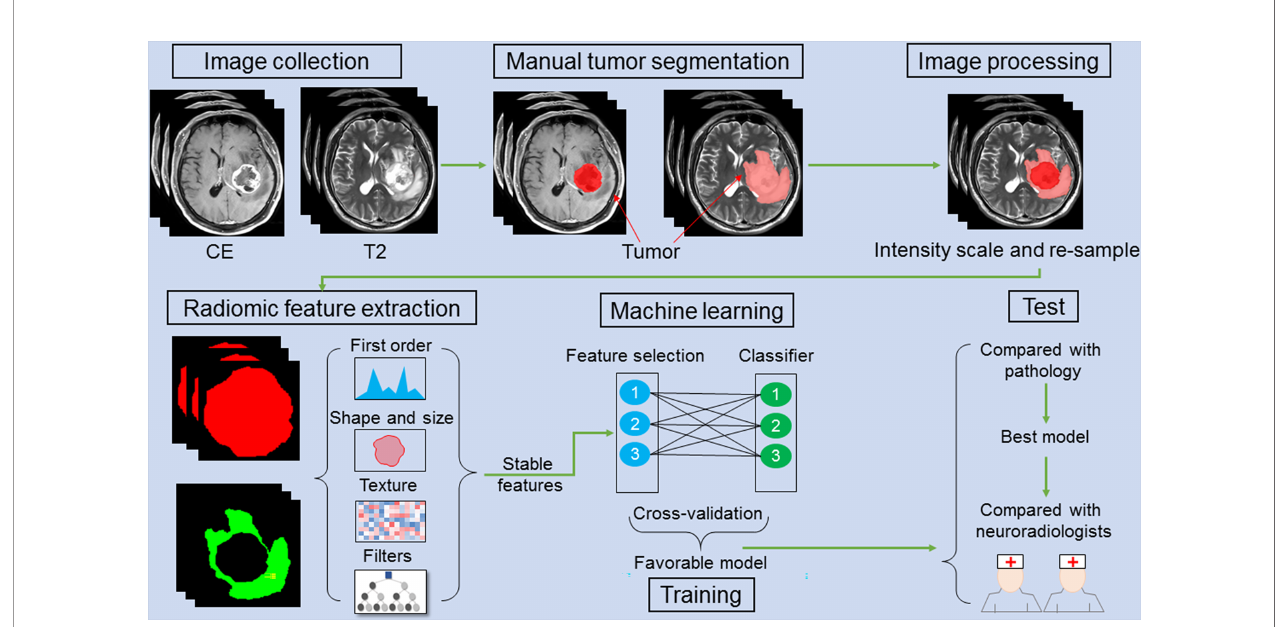
FIGURE 1 | A schematic fi gure shows the radiomic analysis process. After feature extraction, stable features are selected. Three feature selection and classi fi cation methods are combined with favorable models selected and cross-validated in the training cohort. In an independent validation cohort, the optimal model is identi fi ed by comparing with pathology. The performance of the optimal model is compared with that of the two neuroradiologists.